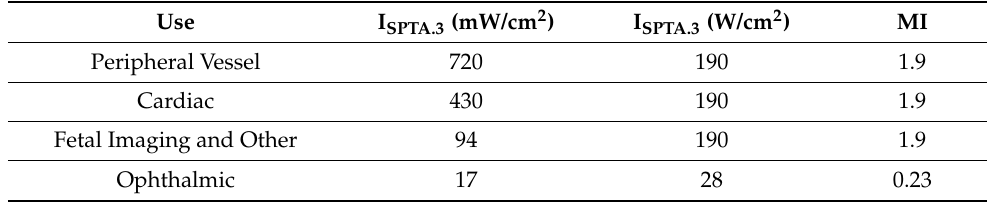
Table 8. Maximum admissible Intensity (MAI): Value for Ultrasonic Noise